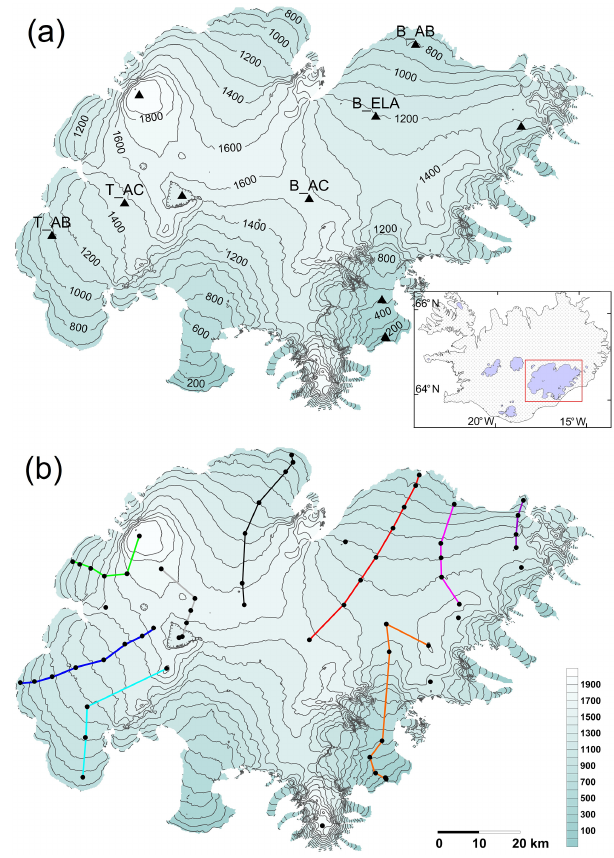
Figure 1. (a) The average location of the AWS sites. Only the la- belled sites were used in this study. (b) The average location of the mass balance sites from 1995 to 2014. The coloured lines connect mass balance sites along a transect. Not all mass balance sites were measured every year.